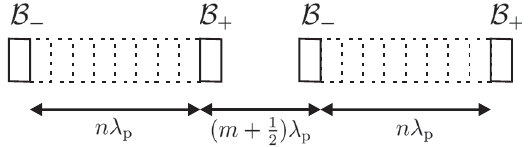
FIG. 8. Boundary field effects can be handled using boundary cells with corresponding B transfer functions. (cid:3)